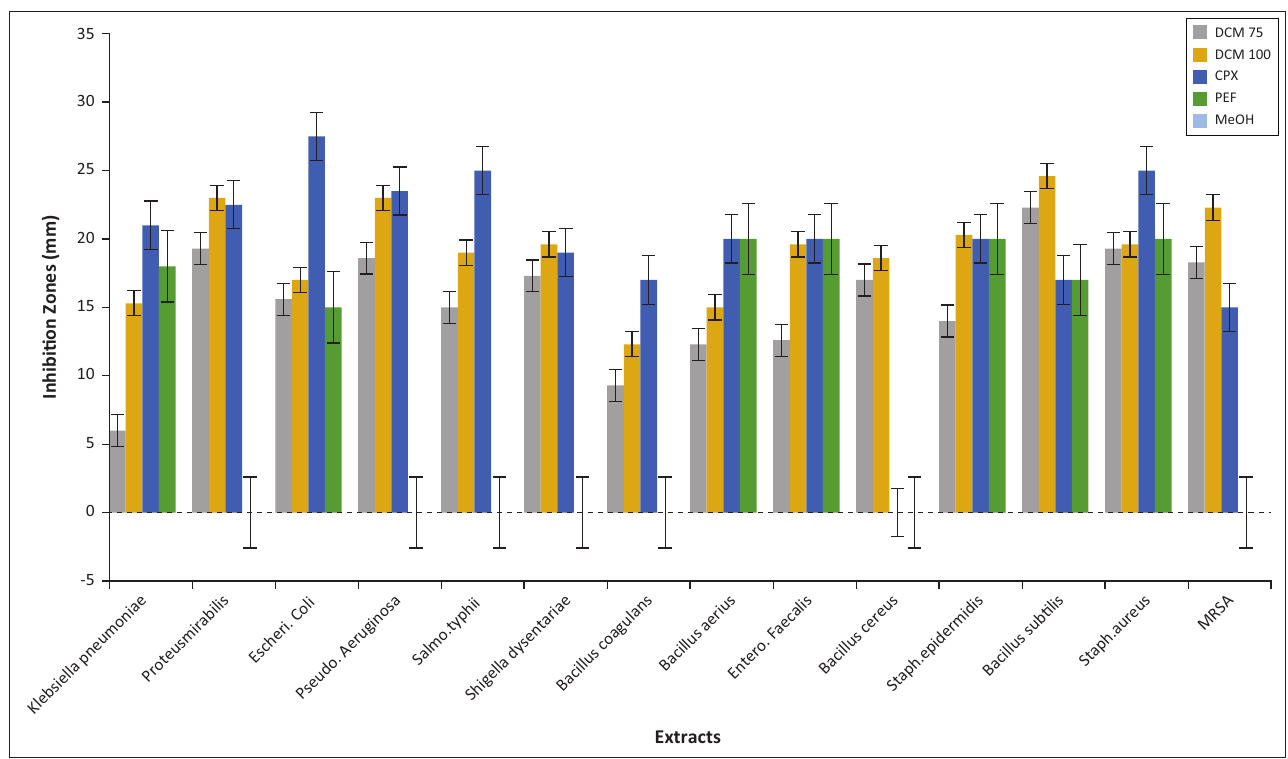
FIGURE 1: Competing activities of the most active extract (dichloromethane – DCM) with the standards (CPX – ciprofloxacin, 10 μg/mL: PEF, pefloxacin, 10 μg/mL, MeOH,